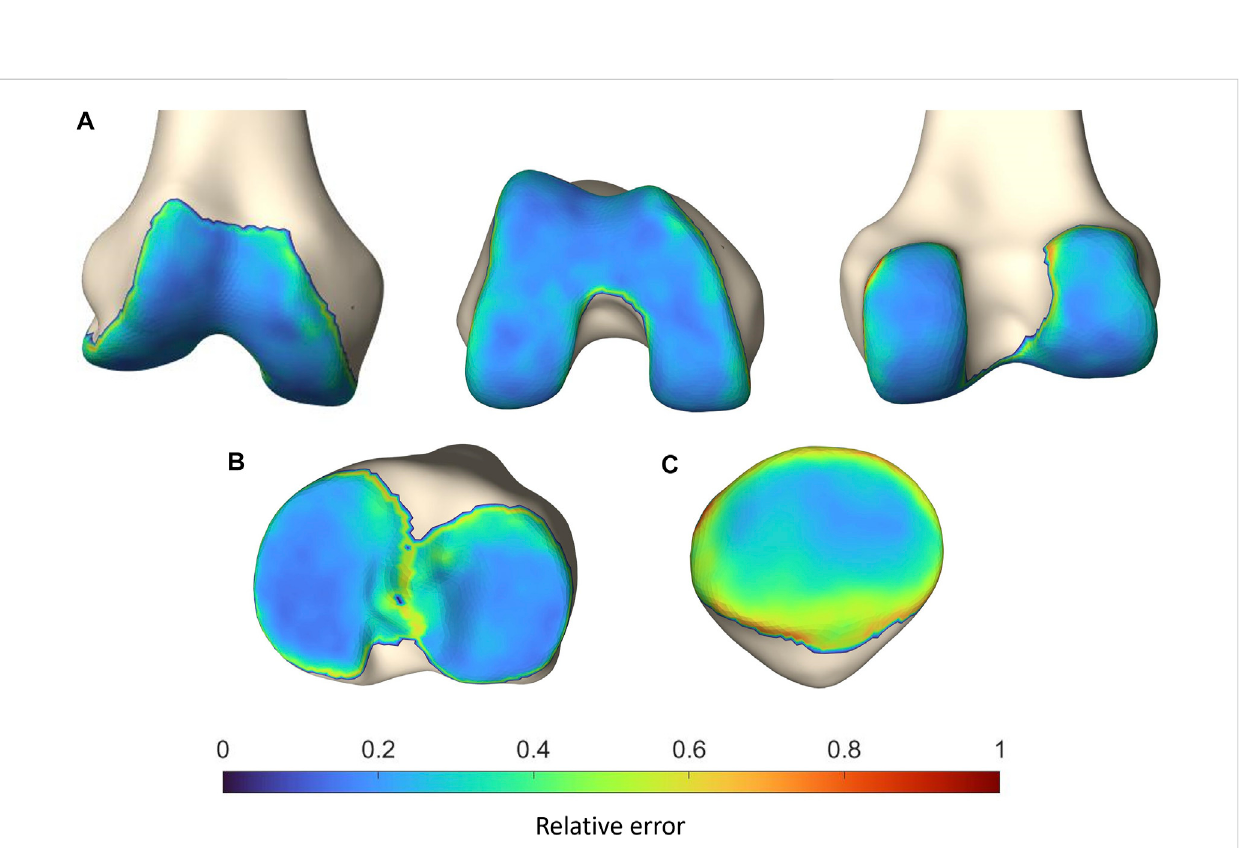
FIGURE 10 Representation of the vertex-speci fi c relative error in cartilage thickness prediction on (A) the mean femur, (B) the mean tibia and (C) the mean patella, extracted from the SSM. Color-coding ranges from blue (absent error) to red (error equaling the point-dependent mean cartilage